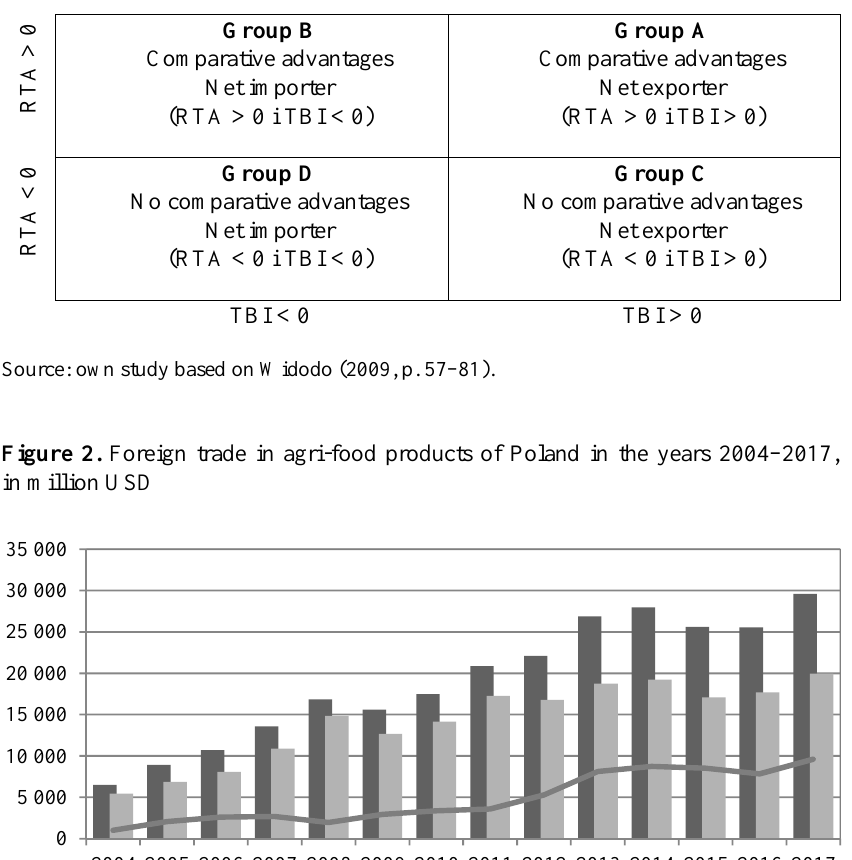
Figure 1. Positioning of products by the level of comparative advantages and export-import relations